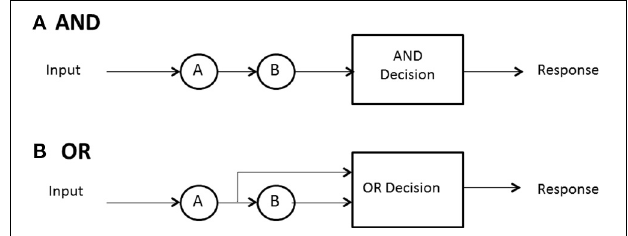
FIGURE 2 | Depiction of stopping rules in a serial system: (A) AND, (B) OR.